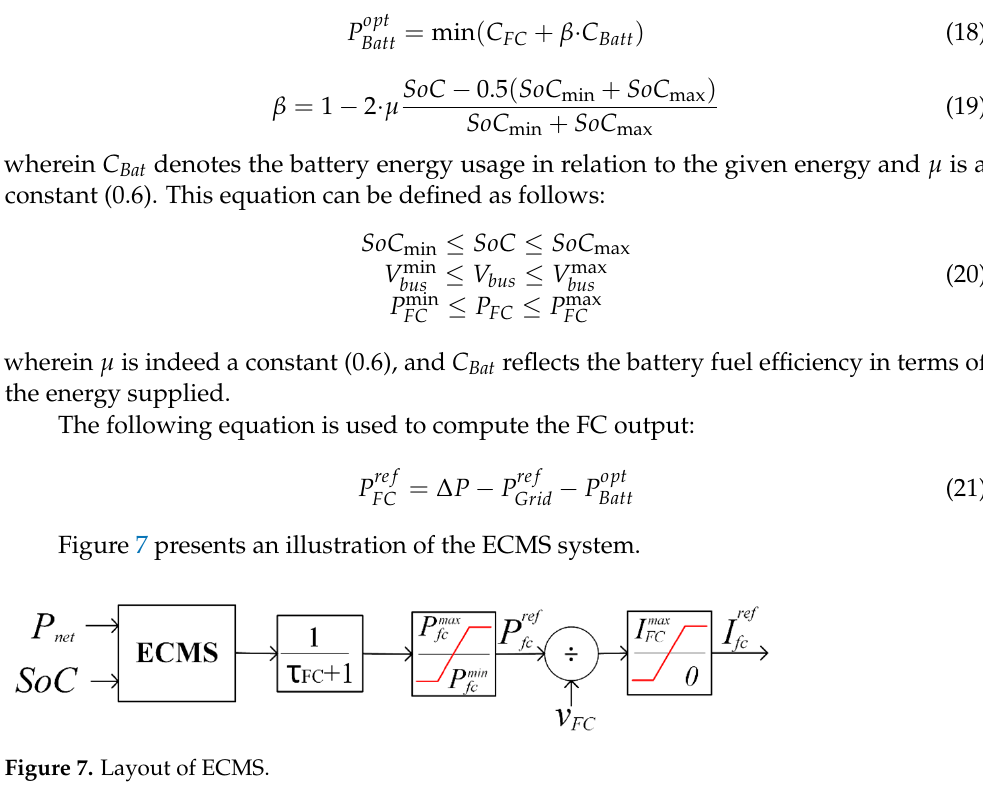
P FCref Figure 8. The scheme of SMC control. The numerical values of parameters addressed in SMCS are: min = 30%; nom2 = 40%; nom1 = 85%; max = 90%; Pfcmin = 850; Pfcmax = 8800; Pfcopt = 1500; PBattmax = 3400 W;